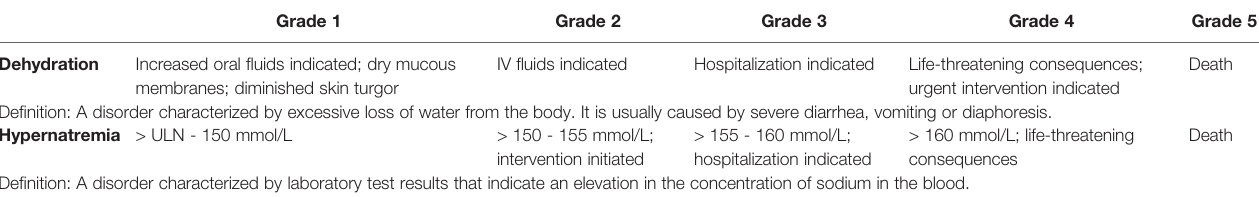
TABLE 3 | Grading system of dehydration and hypernatremia according to CTC-AEs (version 5.0) (49).